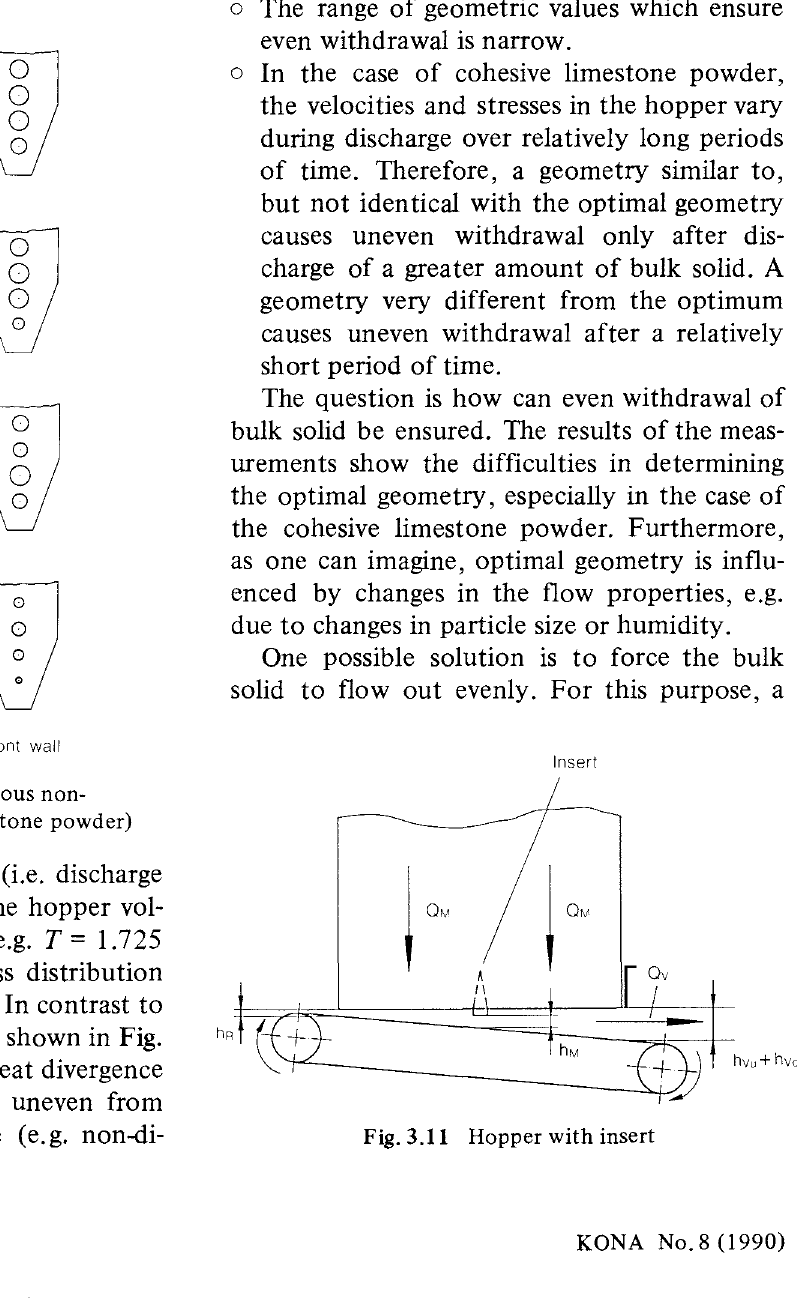
Fig. 3.11 Hopper with